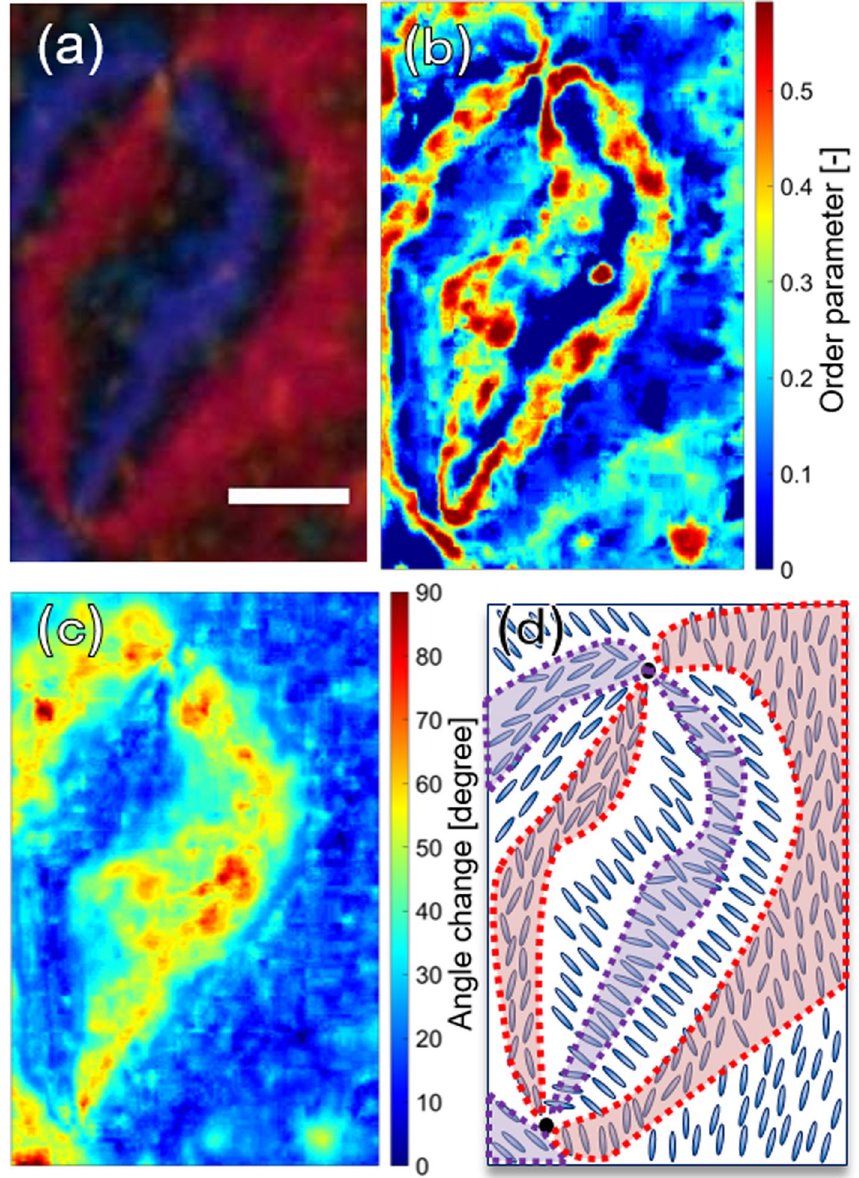
Figure 3. (a) A microscopic color image of MBBA in an LC cell before the irradiation of the UV light is shown. The scale bar corresponds to 20 μm. The predicted images of the order parameter (b) and the orientation angle (c) using the color information of (a) by the neural network function. (d) Based on (b,c) , the schematic drawing of the molecular ordering and orientation is shown (prepared by PowerPoint